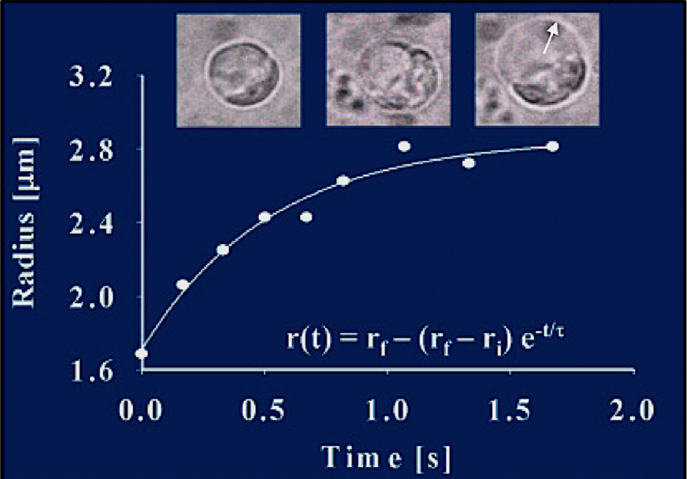
Figure 6. The radial expansion (arrow) of the exocytosed granules follows characteristic first-order kinetics, lending the process to be formalized and evaluated in light of Tanaka’s theory of swelling of polymer gels [27]. This figure illustrates images of video recording of exocytosis in a Phaecystis cell captured at 30 fields × s − 1 . Measurements conducted by digitizing video microscopic images show that, during product release, the radius of the secreted polymer gel increases following first-order kinetics. The continuous line is a non-linear least-square fitting of the data points to r(t) = r f − (r f − t/ τ , where r − r τ is the characteristic i )e i and r f are the initial and final radius of the granule, and relaxation time of swelling.